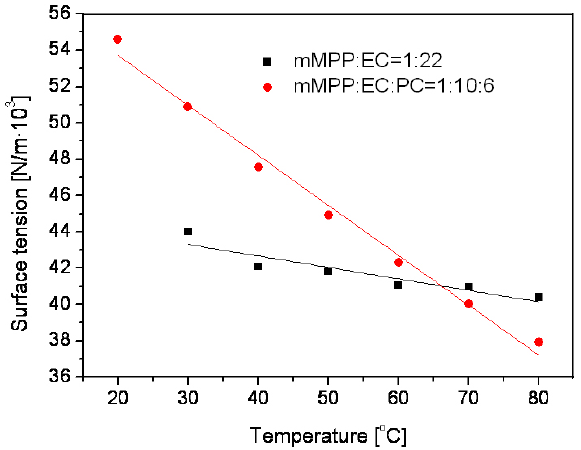
Fig. 7. Dependence of surface tension in function of temperature for the oligoetherols obtained in molar ratio as shown in